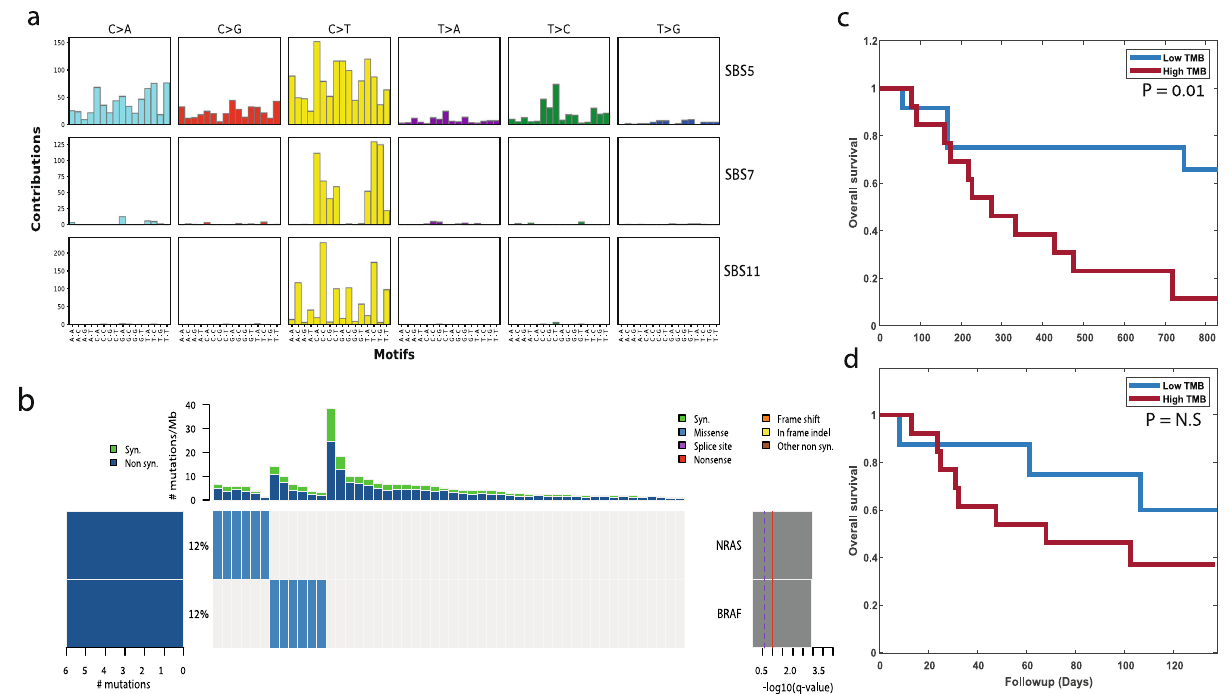
Fig. 4 Pipeline application to an independent dataset. a Mutational signatures identi fi ed based on the set of predicted somatic mutations using the RNA- seq data of 50 pre-therapy biopsies from the Riaz et al. 15 dataset. b Co-mutation plot based on predicted set of somatic mutations. Overall frequencies, allele fractions, and signi fi cance levels of candidate cancer genes identi fi ed by MutSig2CV 44 are shown. c – d Kaplan – Meier survival curves for patients that have previously progressed on ipilimumab ( n = 25). Tumor Mutational Burden (TMB) is estimated based on predicted somatic mutations from RNA ( c ) or based on the list of somatic mutations detected by the authors using tumor and matched-normal DNA ( d ). p -values are computed using logrank test. The patients are split to two groups of low and high TMB using the median TMB value as the cutoff. Source data are provided as a Source Data fi